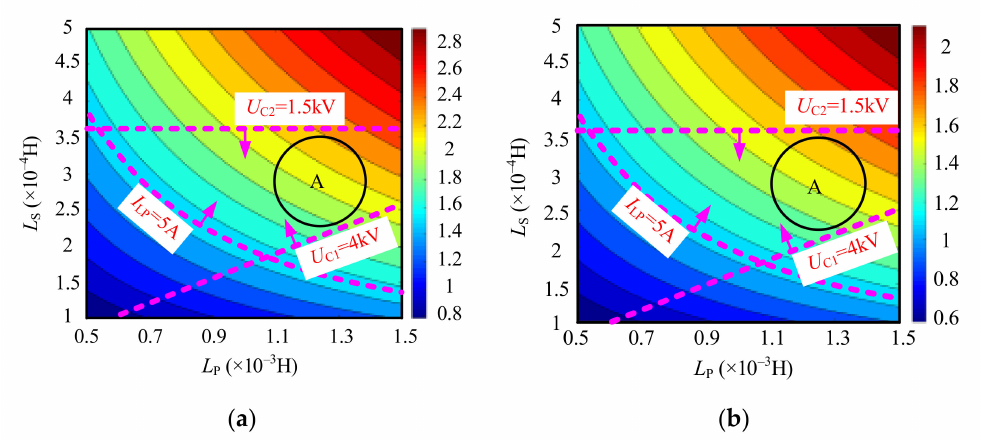
Figure 9. Changes of relative voltage gain G 0 with primary and secondary side self-inductance before and after misalignment. ( a ) Alignment; ( b ) Offset to farthest distance.